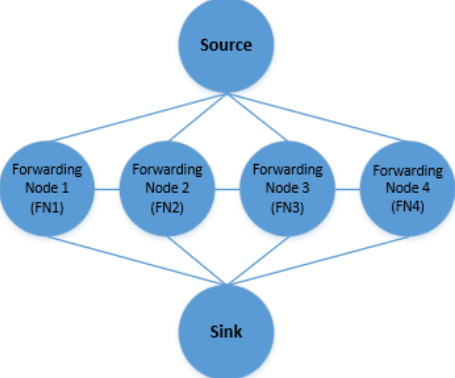
Figure 4. Scenario 2: multipath topology with 6 nodes.